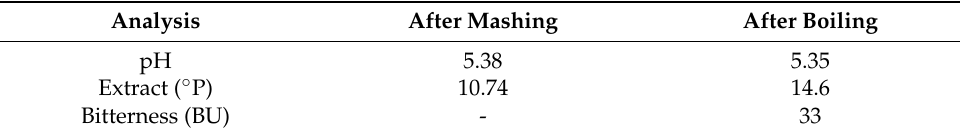
Table 1. Basic physical–chemical indicators of wort after mashing and after boiling. Analysis After Mashing After Boiling pH 5.38 5.35 Extract ( ◦ P) 10.74 14.6 Bitterness (BU) - 33